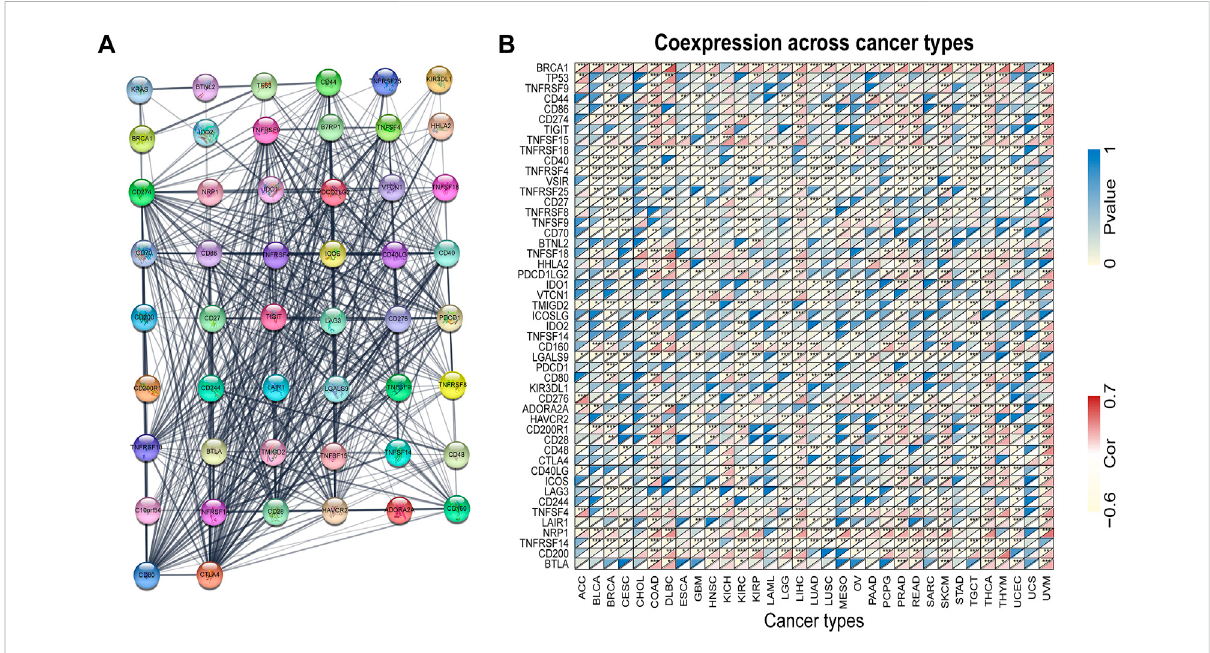
FIGURE 6 KRAS protein-protein network and expression relationships between KRAS and related genes. (A) PPI network for KRAS -interaction genes. (B) Correlation between KRAS expression and related genes (immune checkpoint genes and interacted related genes)